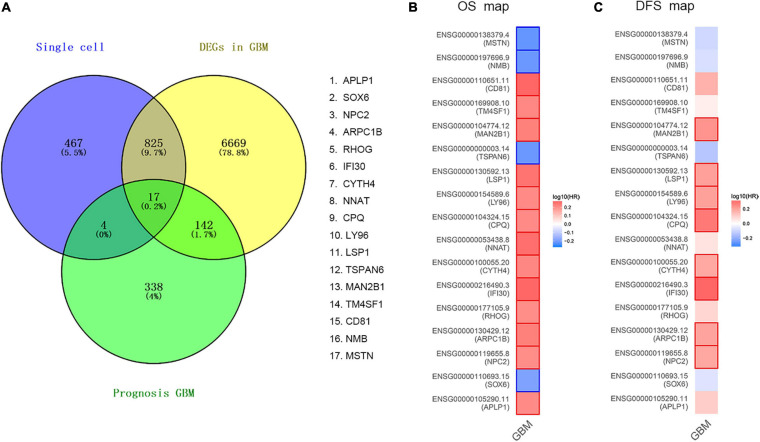
Validation of common DEGs. (A) The common genes between our DEGs, TCGA cohort DEGs, and PRGs of GBM. Different color areas represent different datasets. The cross areas showed the commonly changed DEGs. DEGs were identified with classical t test; statistically significant DEGs were defined with P < 0.001 and | log2 fold change| > 1 as the cut-off criteria. (B) Overall Survival (OS) map of common DEGs. (C) Disease Free Survival (DFS) map of common DEGs.